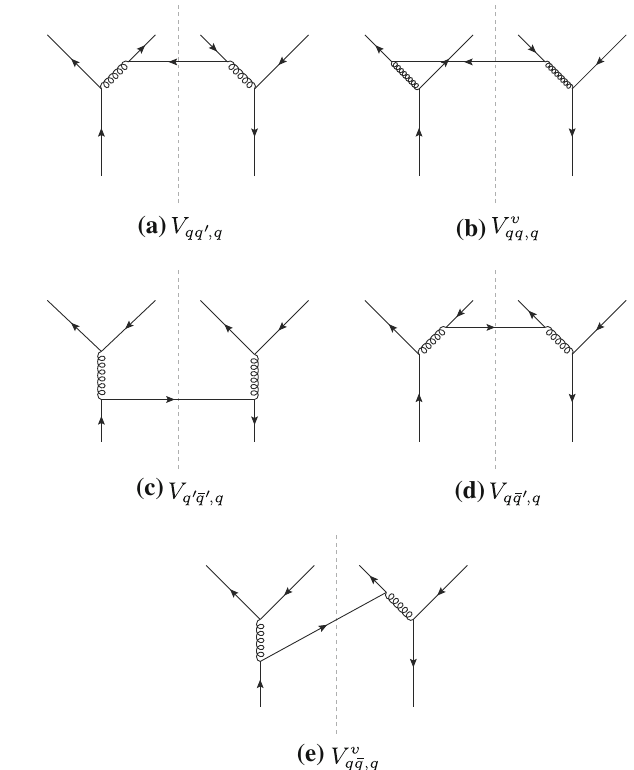
Fig. 5 Real graphs for the splitting a 0 → a 1 a 2 in the pure quark channels. The parton lines at the bottom of the graph correspond to a 0 , andthose on topto a 1 , a 2 , a 2 and a 1 from lefttoright. Additional graphs are obtained by interchanging a 1 ↔ a 2 and by reflection w.r.t. the final state cut with